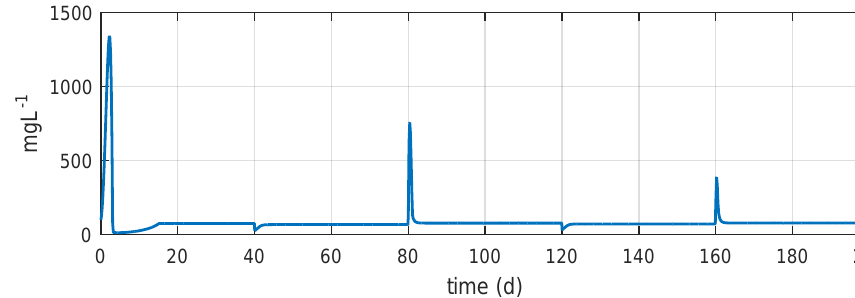
Figure 17. Acetate concentration s in the MEC.